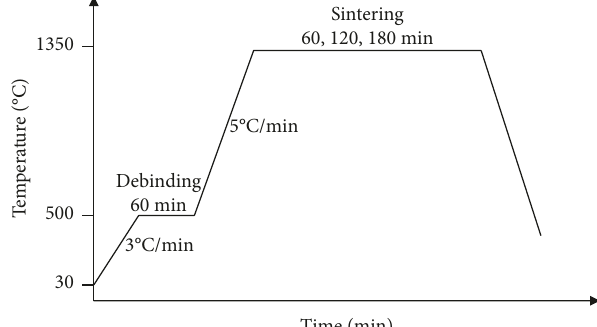
Figure 4: Temperature profile of sintering for calcium titanate